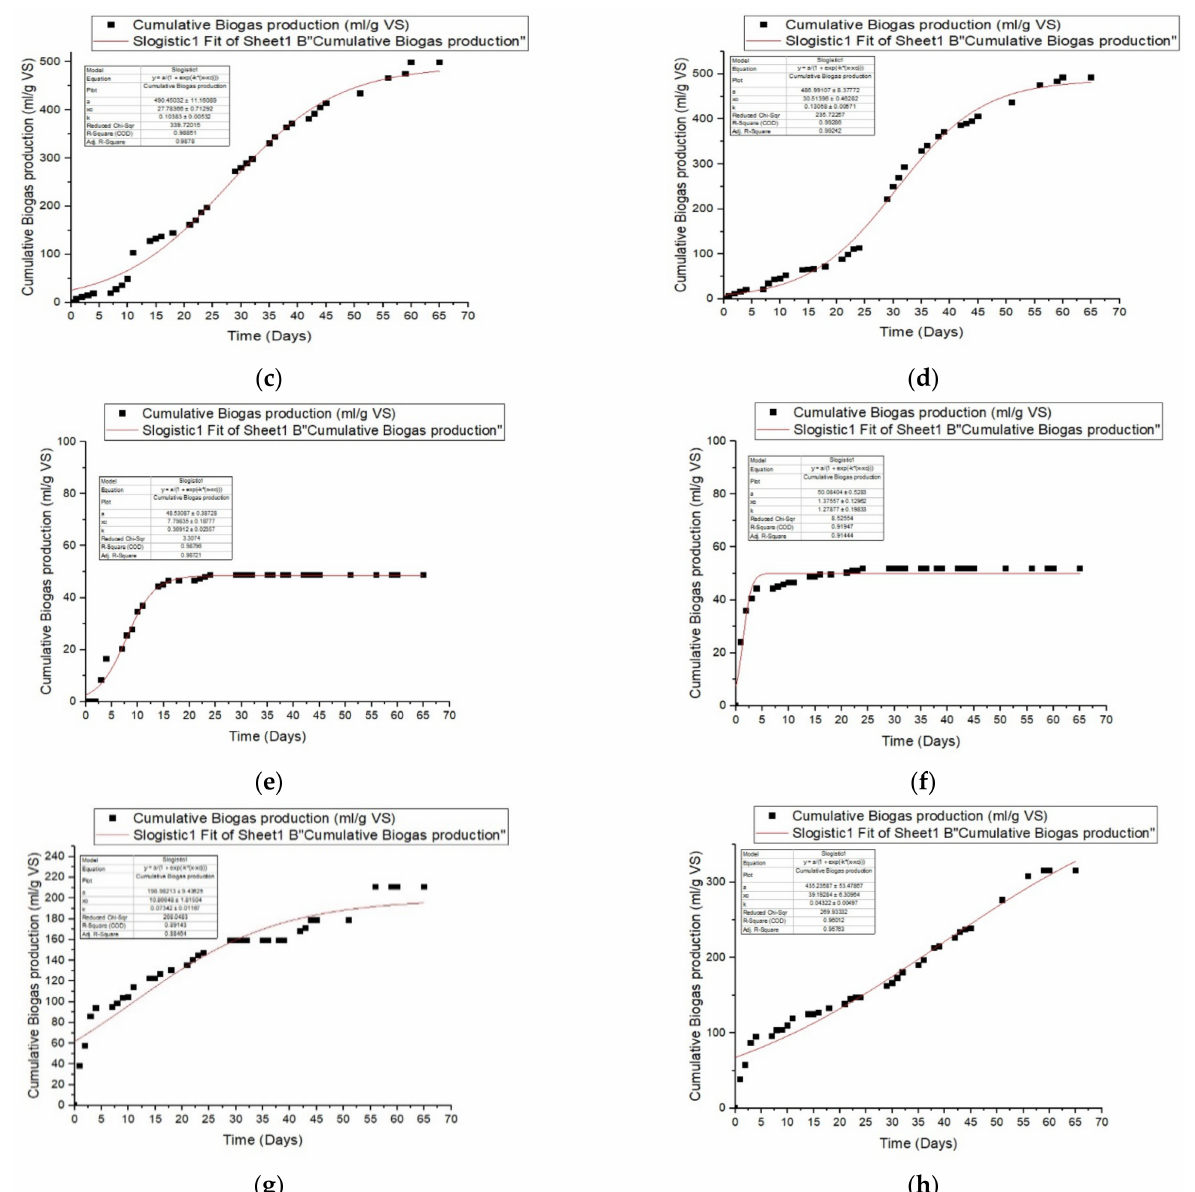
Figure 8. Cumulative biogas yield from Logistic model, Manure ( a – d ) and Sludge ( e – h